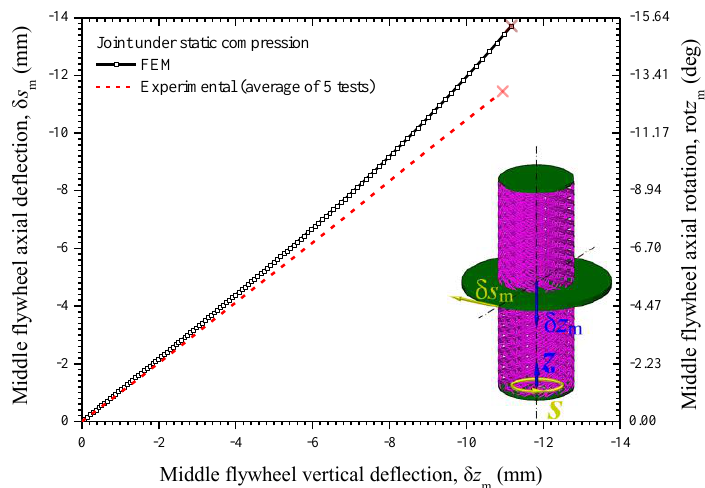
Figure 10. Relation between twisting and the vertical axial deflection of the middle flywheel due to the joint axial compression.